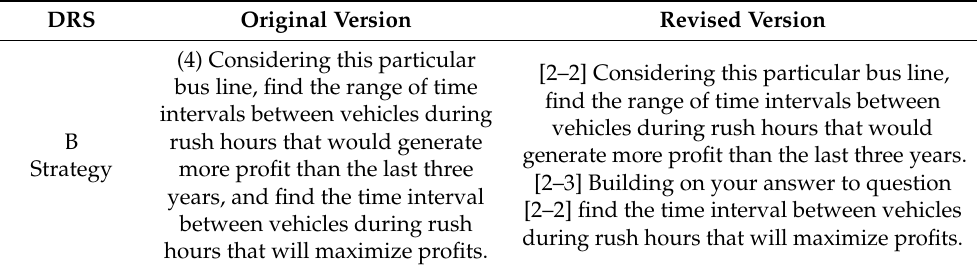
Table 7. B Strategy (Breaking the Task into Smaller